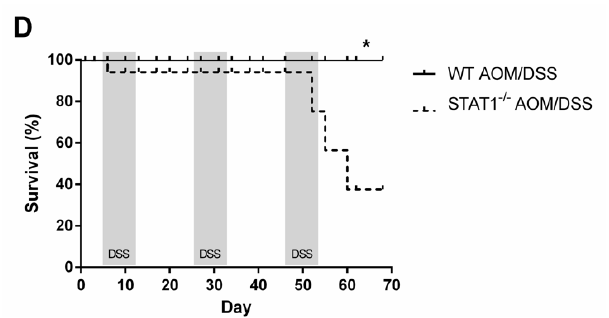
Figure 1. Changes during the course of colorectal cancer (CAC) in WT and signal transducer and activator of transcription (STAT1) deficient mice (STAT1 − / − ). ( A ) Schematic time schedule of azoxymethane (AOM) and dextran sodium sulfate (DSS) administration. After the initial AOM injection (12.5 mg/kg), DSS was given in drinking water for seven days followed by 14 days of regular drinking water. Mice were sacrificed on Days 20, 40 (early tumor development), and 68 (late tumor development) post AOM injection. ( B ) The disease activity index score (DAI) was assessed on the indicated days for each animal and averaged per day for each group (mean ± SEM, n = 5 mice/group). ( C ) Weight changes in healthy mice and AOM/DSS-treated mice relative to initial body weights during the course of the experiment. The graph shows data from four independent experiments (mean ± SEM, n = 5 mice/group). One-way ANOVA and Tukey´s multiple comparisons tests were completed. * represents p ≤ 0.05, *** represents p ≤ 0.001. There was a significant difference between WT AOM/DSS versus STAT1 − / − AOM/DSS at the indicated time. ( D ) Survival curve comparing WT AOM/DSS (black solid line, n = 5) versus STAT1 − / − AOM/DSS WT (dashed line, n = 8). There was a significant difference in survival between WT AOM/DSS and STAT1 − / − AOM/DSS (log rank test, * p = 0.0074). Data were pooled from two independent experiments. Cancers 2018 , 10 , x FOR PEER REVIEW